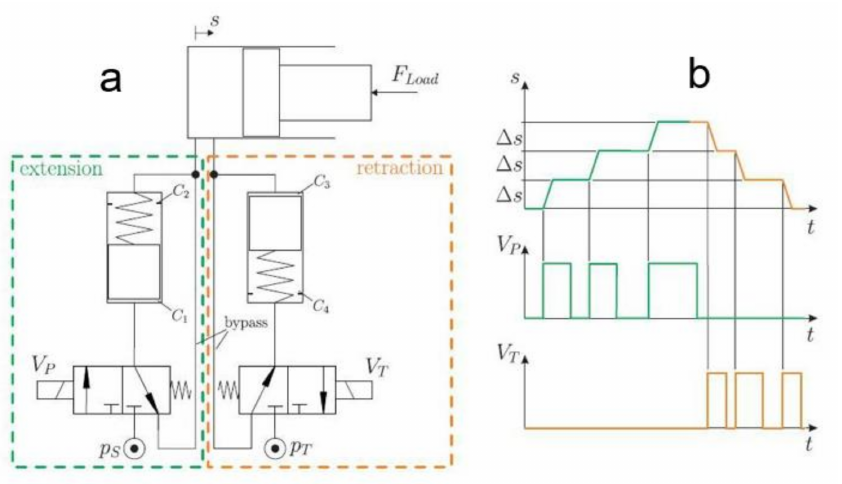
Figure 2. Schematic of an energy efficient stepping converter [14]; sub-figure ( a ): concept for operation in both directions; subfigure ( b ): valve timing diagram and actuator motion s(t)